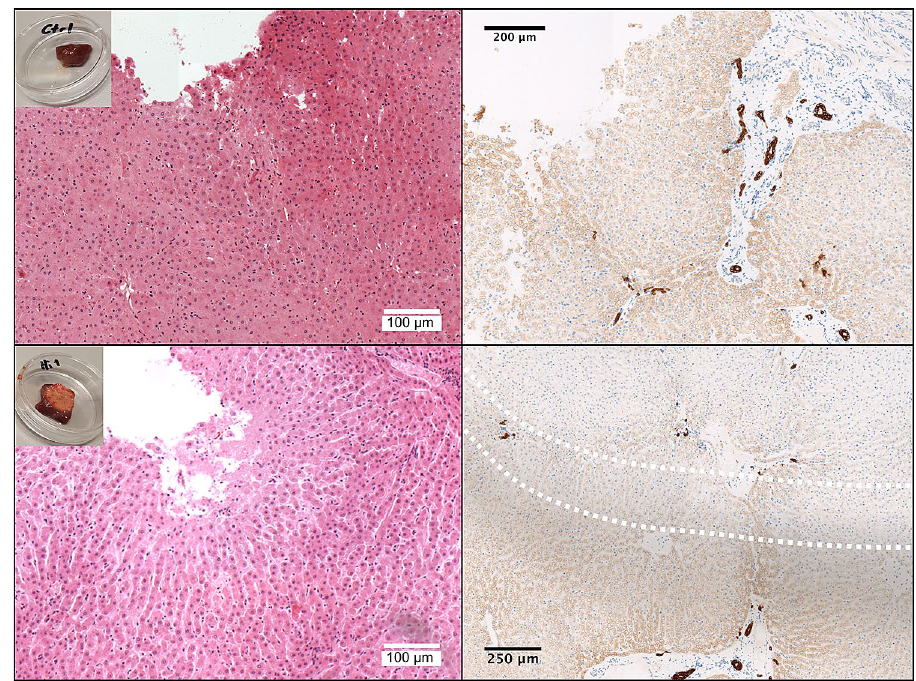
Figure 9. Immunohistochemistry of HIFU-ablated ex-vivo bovine liver exposed to 8.2 MPa peak-to-peak. H&E (left column) and pan-CK microscopy at ×20 of control sample (top row) and HIFU-exposed sample (bottom row). Insets of macroscopic samples shown in the top left corner of H&E images. Microscopy was taken at lesion edge which was clearly defined in the case of pan-CK but less easily distinguished with H&E. H&E of the HIFU-ablated liver demonstrates distinct cellular margins, subtle loss of some nuclear stain and occasional haemorrhagic foci. The dotted lines in the HIFU-ablated pan-CK sample (bottom right) demonstrate an approximate 300 µm transition zone of some viable hepatocytes between viable cells (below, positive staining) and non-vital hepatocytes (above, negative staining). The bile ducts are noted to stain strongly, regardless of HIFU exposure (dark